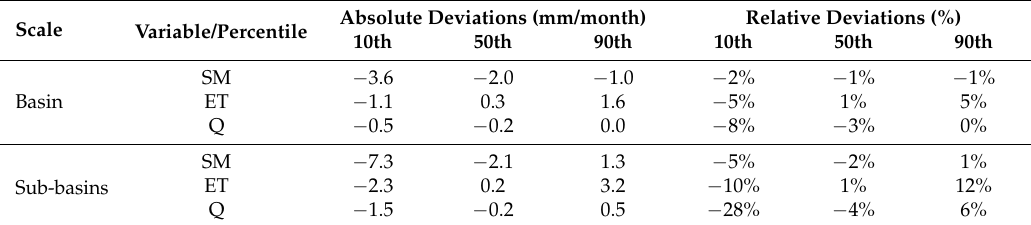
Table 3. Absolute and relative deviations for the 3_FAOseas run compared to the 0_NDVIref run, indicating the 10th, 50th (median) and 90th percentiles, for the basin and the sub-basin scale.